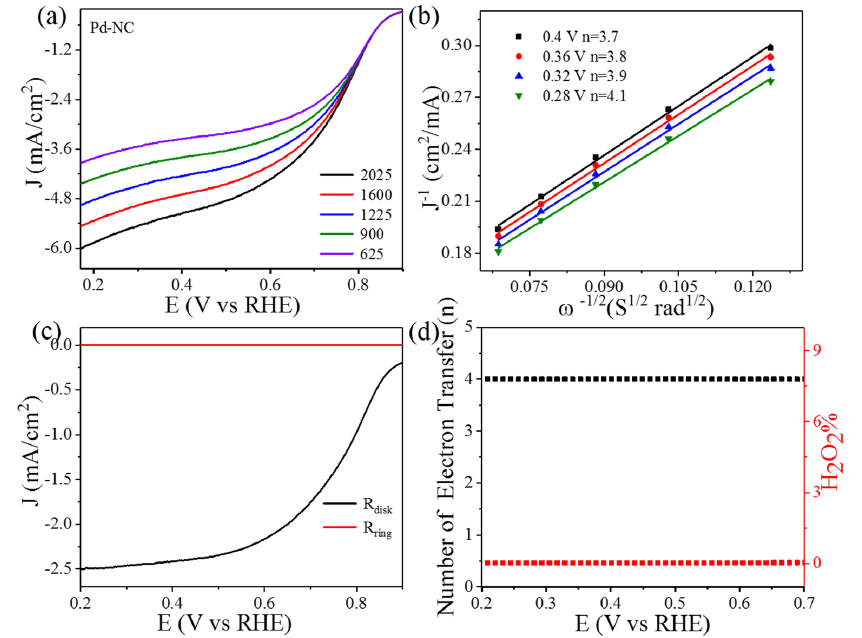
Figure 5. RDE tests ( a ) and corresponding K-L lines ( b ) of Pd-NC in oxygen saturated 0.1 M KOH at various rotation speeds with the sweeping rate of 0.005 V s − 1 . RRDE test ( c ) and the corresponding electron transfer numbers ( n ) and H 2 O 2 % ( d ) of Pd-NC at 1600 rpm with the same sweeping rate.